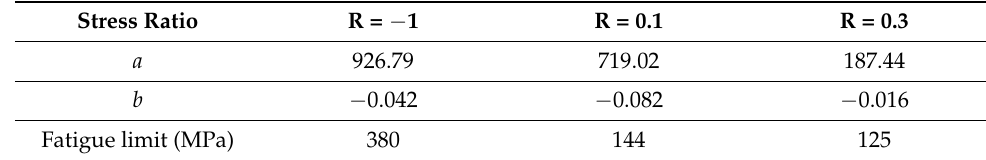
Table 3. Results of S-N curves fitting by the Basquin3